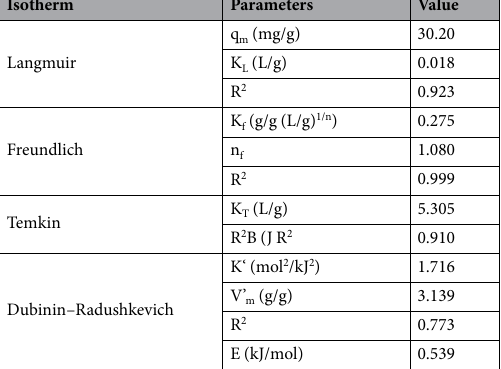
(C e ) which are investigated in Table 1 with their correlation coefficient, R 2 . The line intercept, K f gives a rough indication about the adsorption affinity and the slope, n f , gives prediction about the effectiveness of adsorption process. Figure 8-b demonstrates the linear plot of Freundlich isotherm. The correlation coefficient is determined as R 2 = 0.9996, which is agreed with the experimental results of the oil adsorption process. This result evident that the oil adsorption process onto NMAC follows the Freundlich equation. The calculated values of n f , were greater than 1 that indicates favorable oil adsorption onto NMAC 37 . The value of Freundlich constant specifies facile oil removal from aqueous solution. Regarding to Freundlich isotherm exhibited the greatest fitting, this supposed that there is a heterogeneity on NMAC surfaces or its pores had as significant role in the oil sorption 34 . Temkin reflected the influences of indirect relationships between adsorbent and adsorbate on the adsorption isotherm that suggested adsorption is described by a homogeneous binding energies distribution that equal to specific maximum binding energy 37,38 . Plotting of q e versus ln (C e ) allows estimation of slope and intercept to determine the isotherm constants B and K T respectively. The Temkin model parameters and its correlation coef- ficient, R 2 are tabulated in Table 1. Figure 8-c demonstrates the linear plot of Temkin isotherm. Its correlation coefficient value of R 2 = 0.919 indicating relatively poor fitting to the isotherm equation.